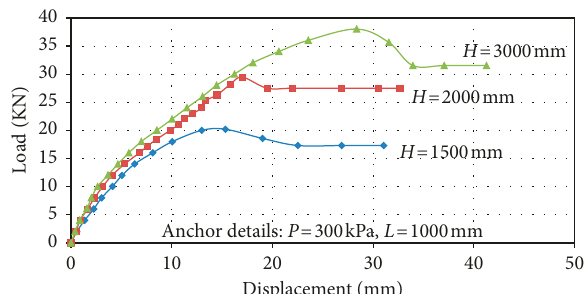
Figure 7: Anchor pullout force versus displacement for various embedment